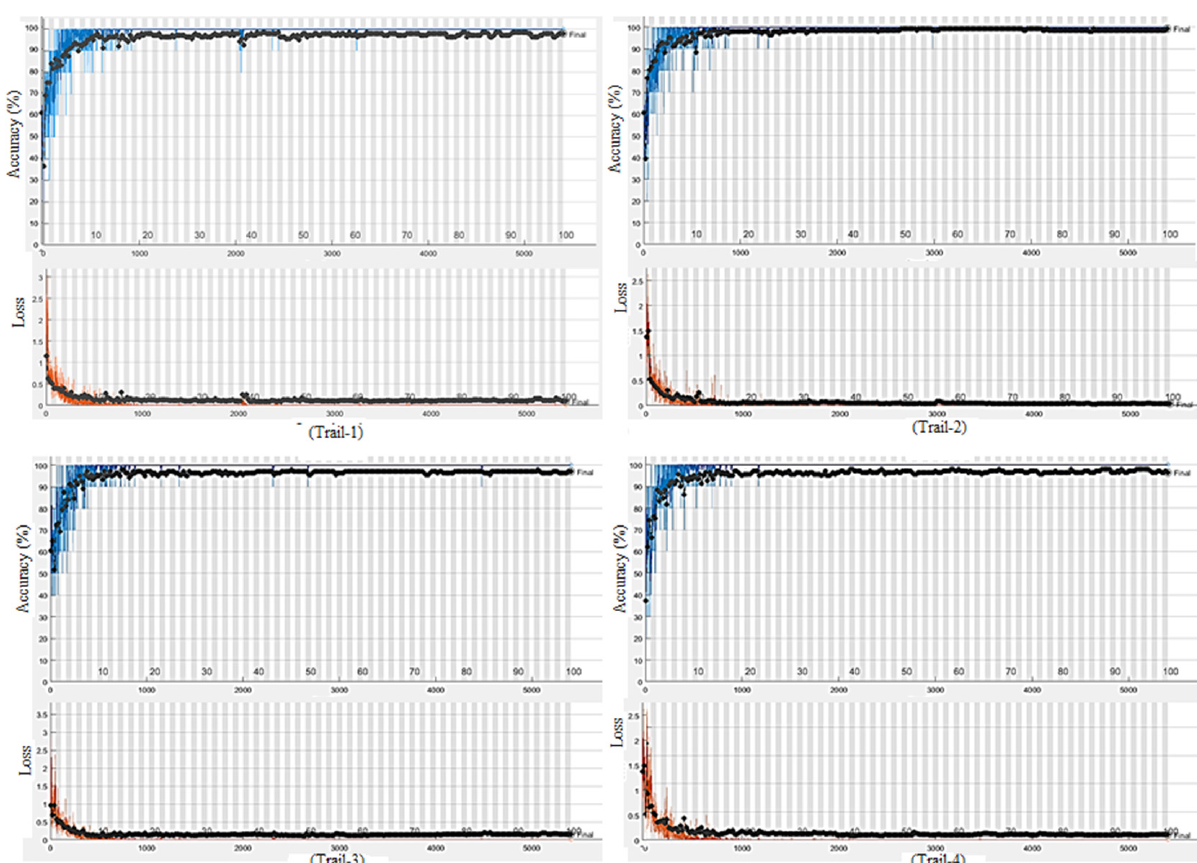
Figure A2. Sample training curve of four rounds of the experiment (ResNet18, FLAIR).